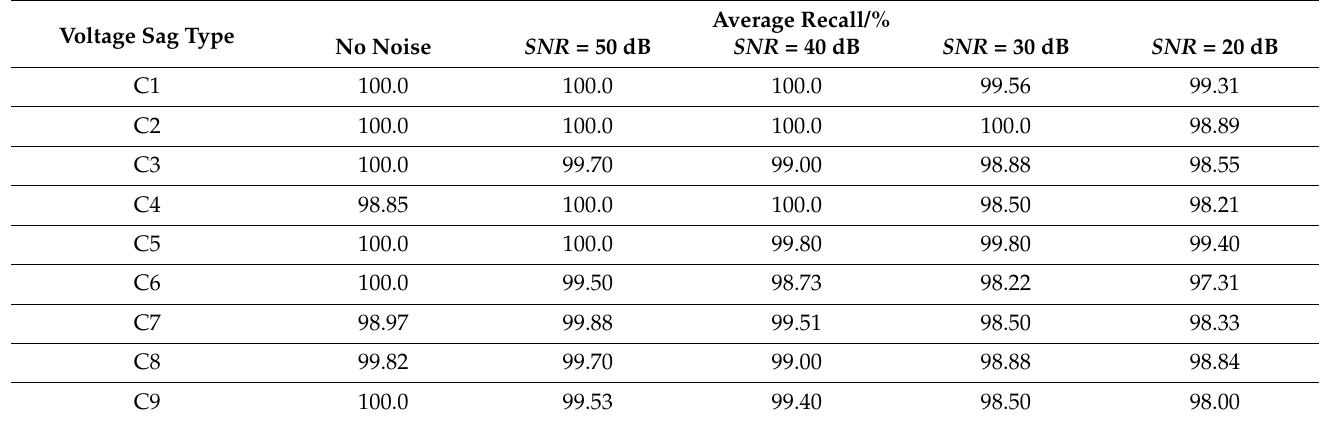
Table 2. Classification results of the model under different noises.